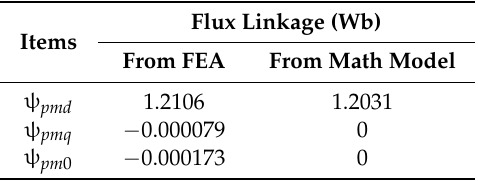
Table 2. PM flux linkage in d-q reference frame. FEA: finite element analysis. Flux Linkage Items